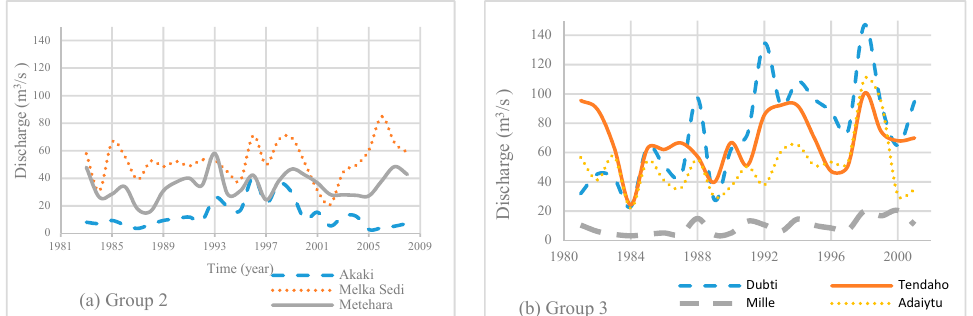
Figure 10. Temporal annual and seasonal streamflow variability in the ARB; Group 2 (1983–2008), and Group 3 (1981–2001) .